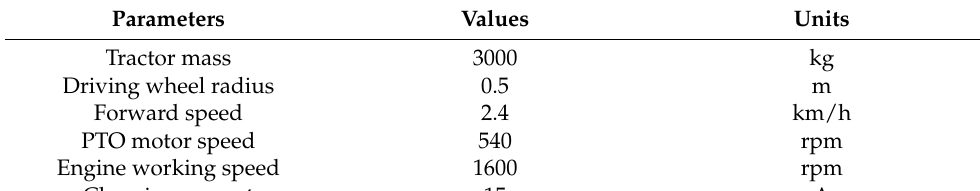
Table 2. Primary setting parameter values of the test scenario.